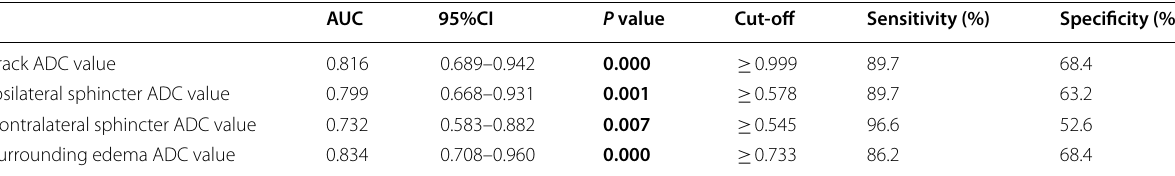
Table 2 ROC curve analysis for ADC measures